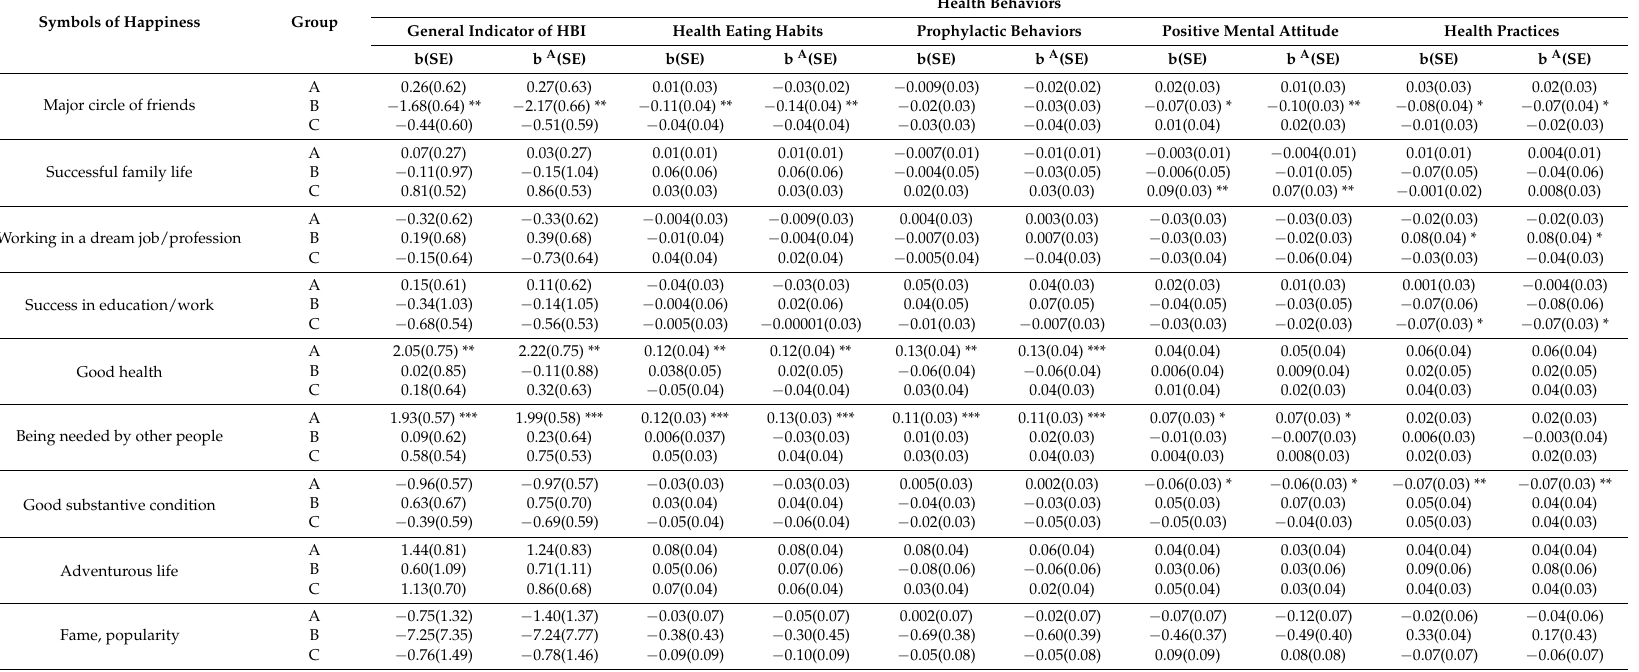
Table 5. Relationship between symbols of happiness and health behaviors of surveyed